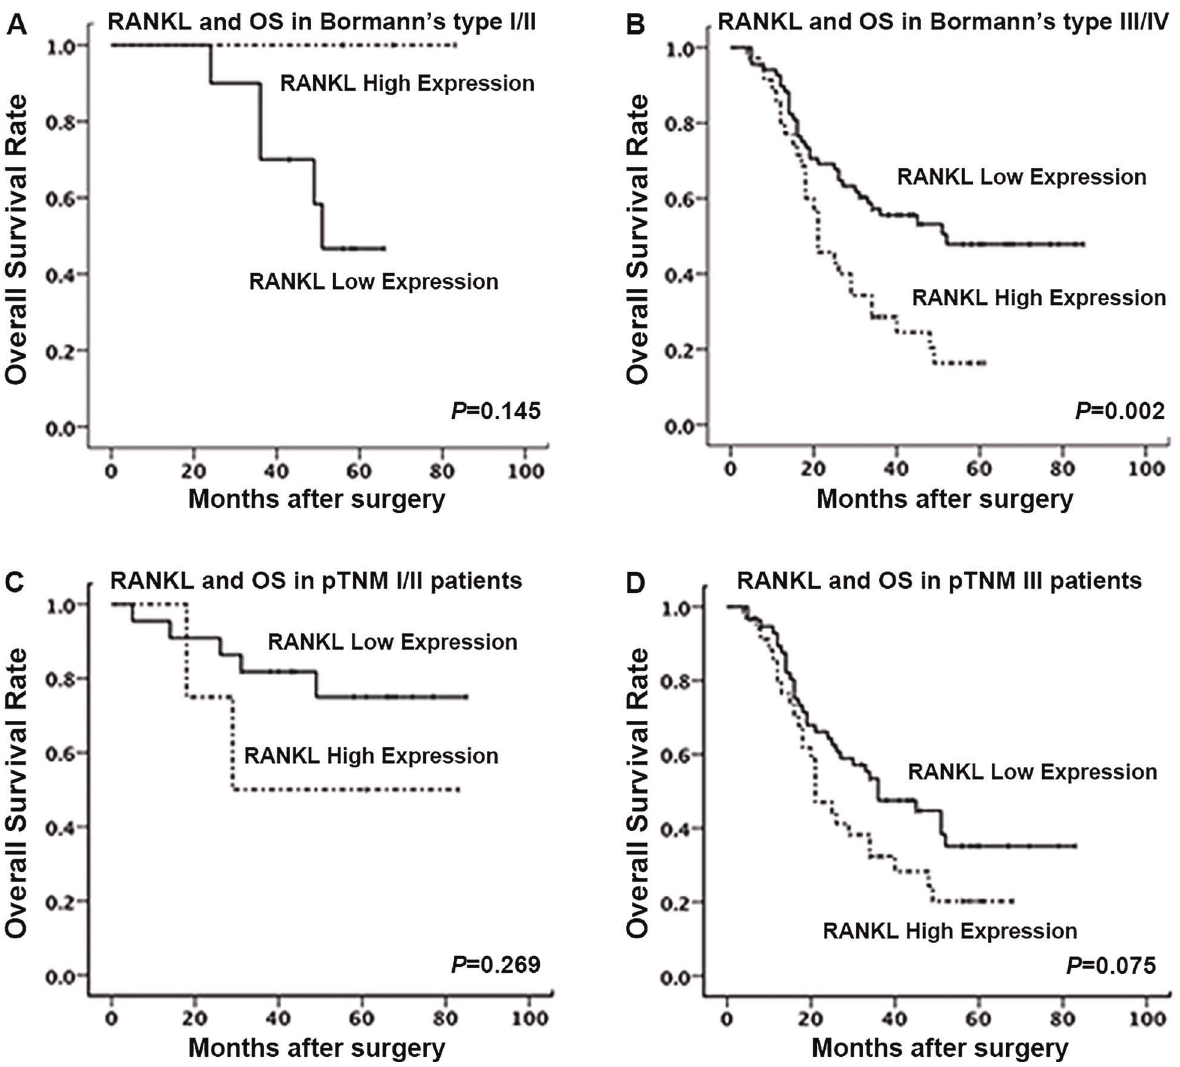
Figure 3. Prognostic signi fi cance of RANKL expression according to different clinicopathological factors in gastric cancer patients. Kaplan-Meier analysis of overall survival for the RANKL expression in Bormann ’ s type I/II ( A ) or III/IV ( B ) patients, and for pTNM stage I/II ( C ) or III ( D ) patients. pTNM: pathological tumor/lymph